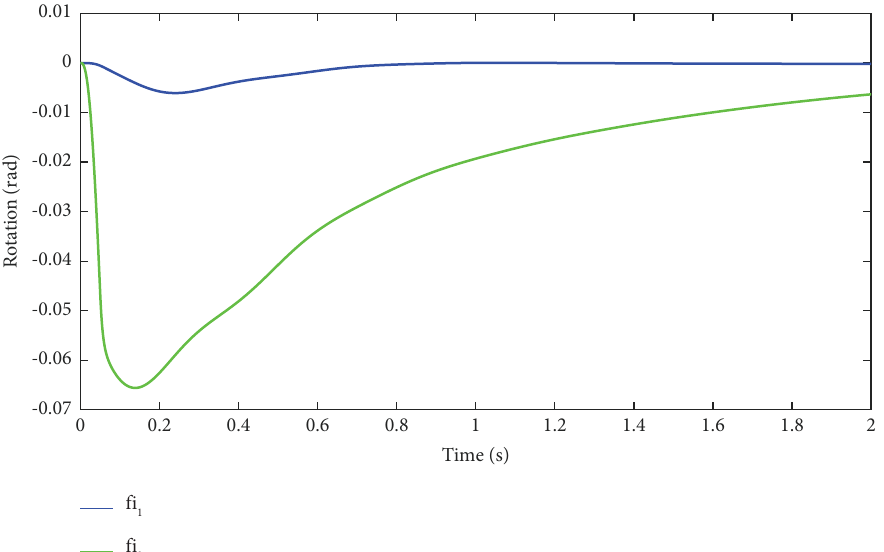
Figure 5: Angular displacements of parts of the mobile antiaircraft weapon system after the launch: φ body and φ 2 -angular displacement of the